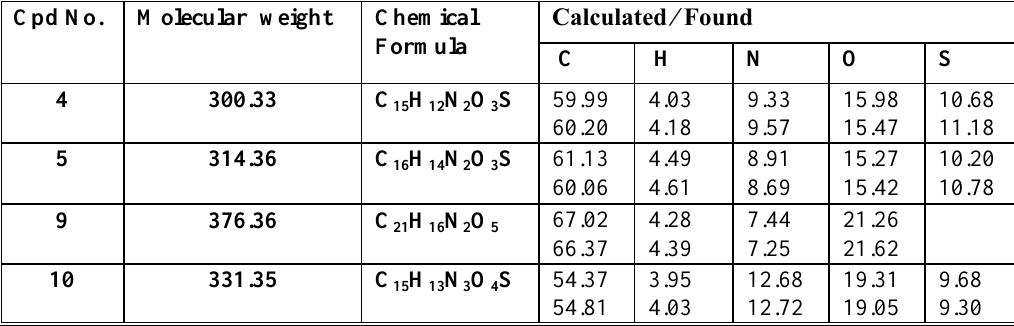
Table 2: Elemental analysis % of the final products Cpd No.